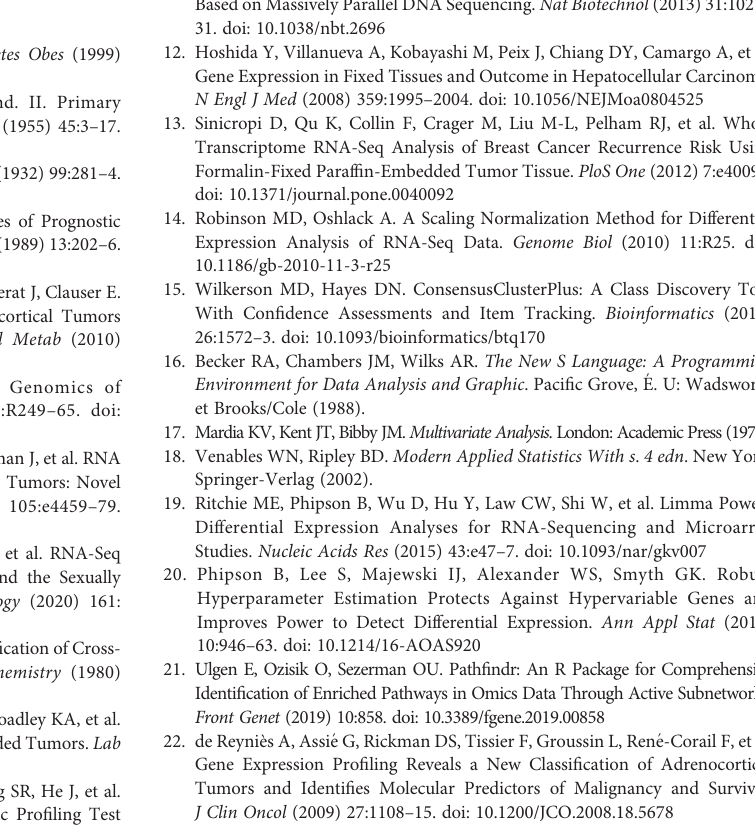
Supplementary Figure 1 | Comparison of RNA yield and quality parameters between two storage period groups. FFPE samples were divided into two groups by 340 days, the median storage period. Similarly, fresh-frozen samples were divided by 427 days. Supplementary Figure 2 | Distribution of the logCPM values of IGF2 . Dots; each sample. Supplementary Figure 3 | Heatmap showing the results of KEGG pathway analysis of DEGs between APA and CPA (common to FFPE and fresh frozen samples). Score; the agglomerated z score of each enriched KEGG pathway per